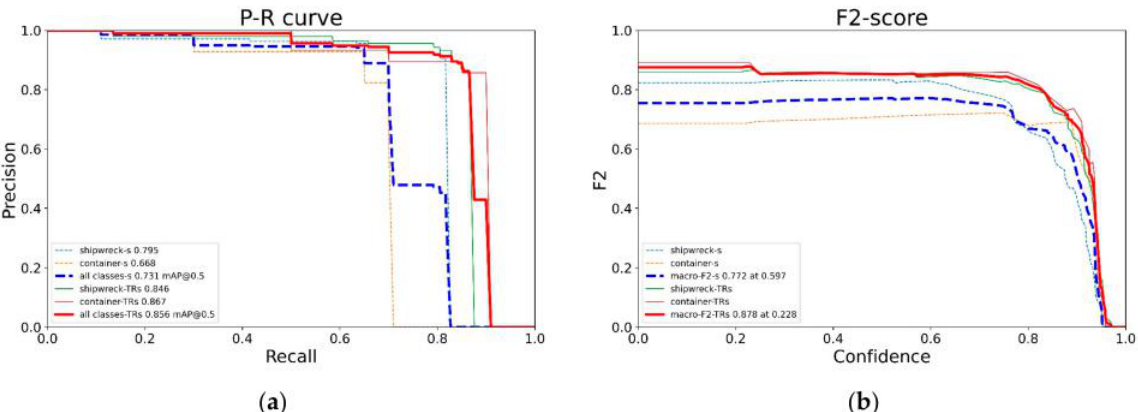
Figure 18. The P–R curves and F 2 score curves of YOLOv5s and pre-trained TR–YOLOv5s: ( a ) the P–R curves of two detectors in shipwreck and container detection; ( b ) the F 2 score curves of two detectors in shipwreck and container